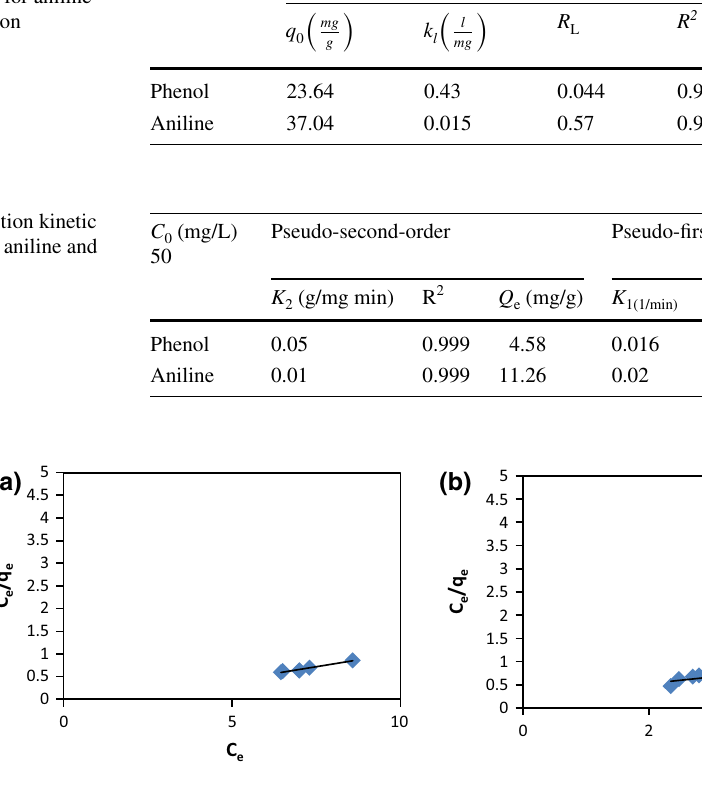
Fig. 7 Langmuir isotherm plot on a aniline and b phenol removal by bentonite